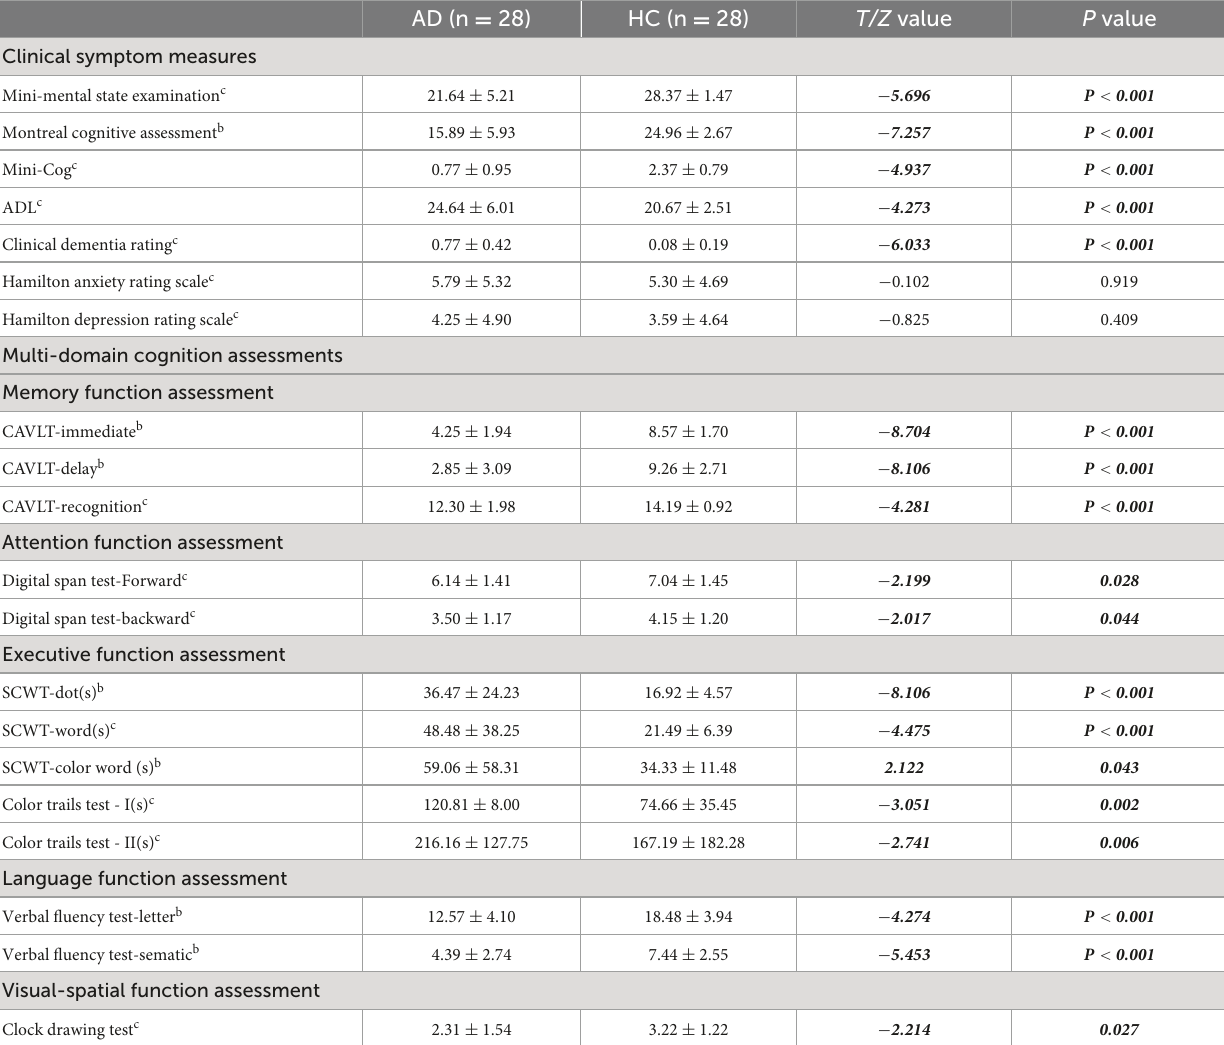
TABLE 1 Neuropsychological tests of AD and HCs (x ±